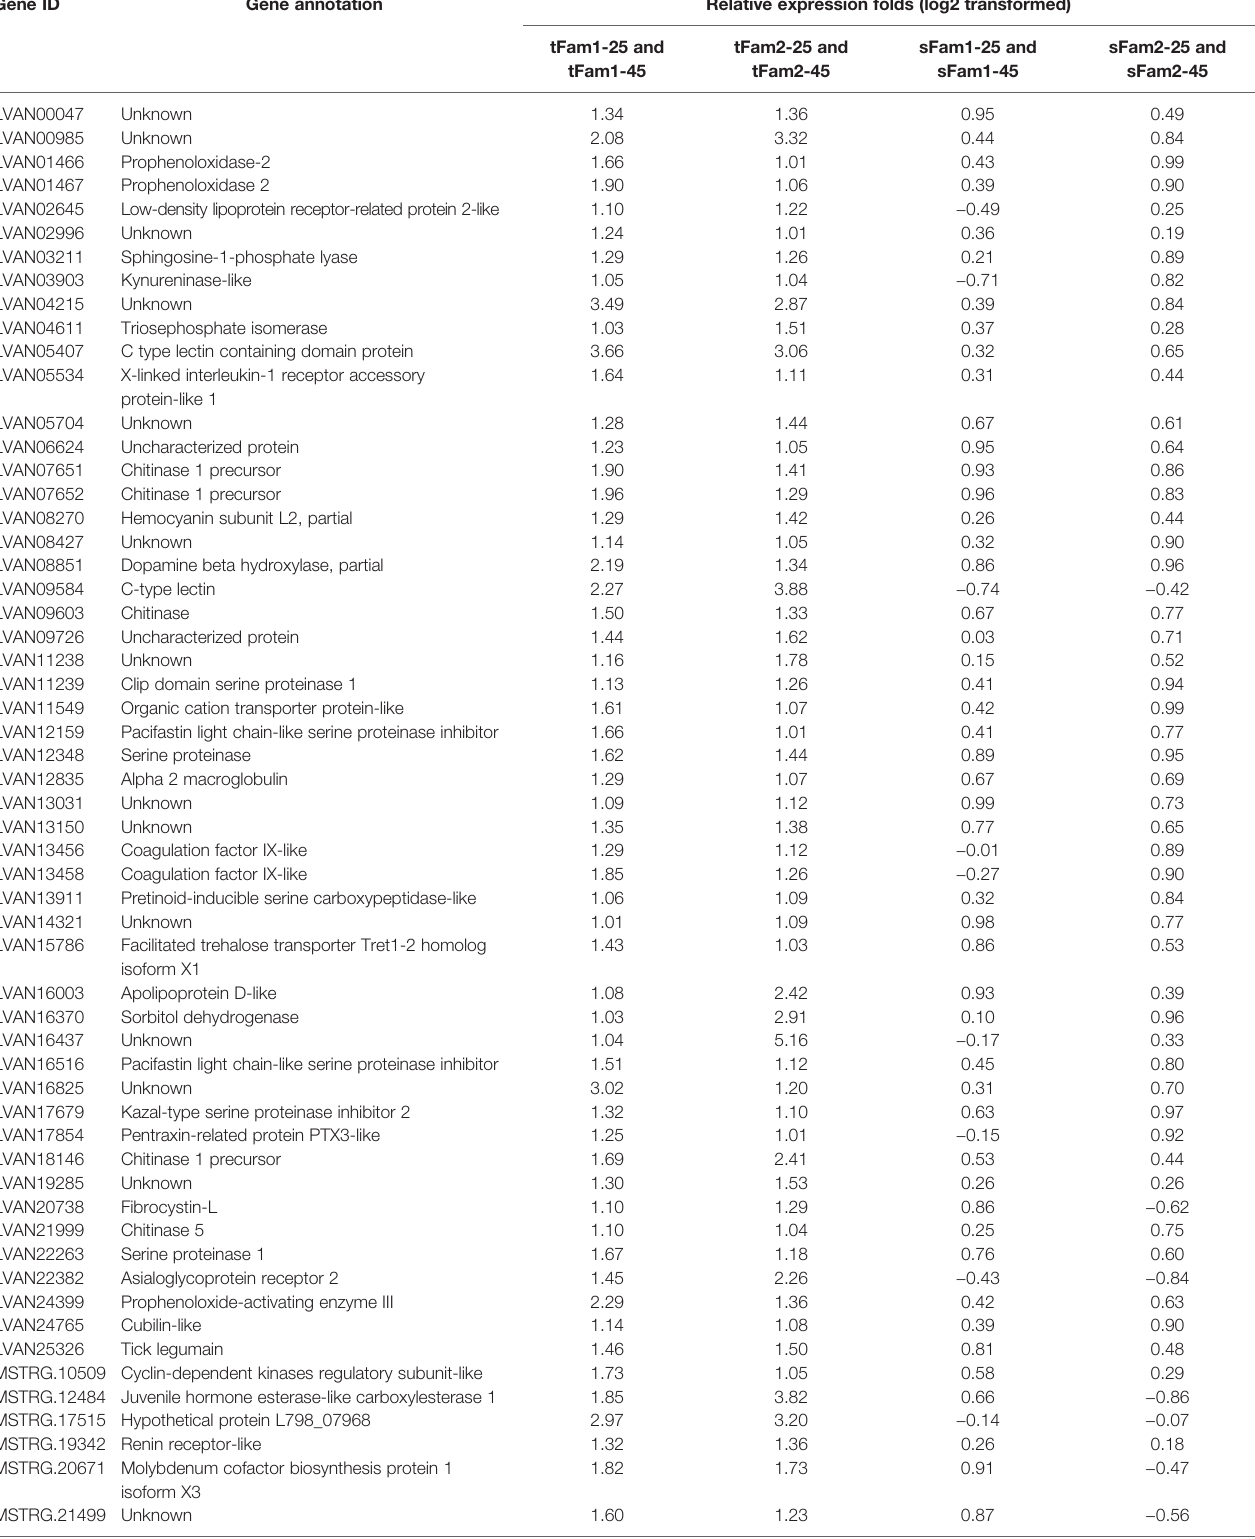
TABLE 3 | Genes upregulated signi fi cantly in tolerant families but not signi fi cant in susceptible families under high-salinity stress. Gene ID Gene